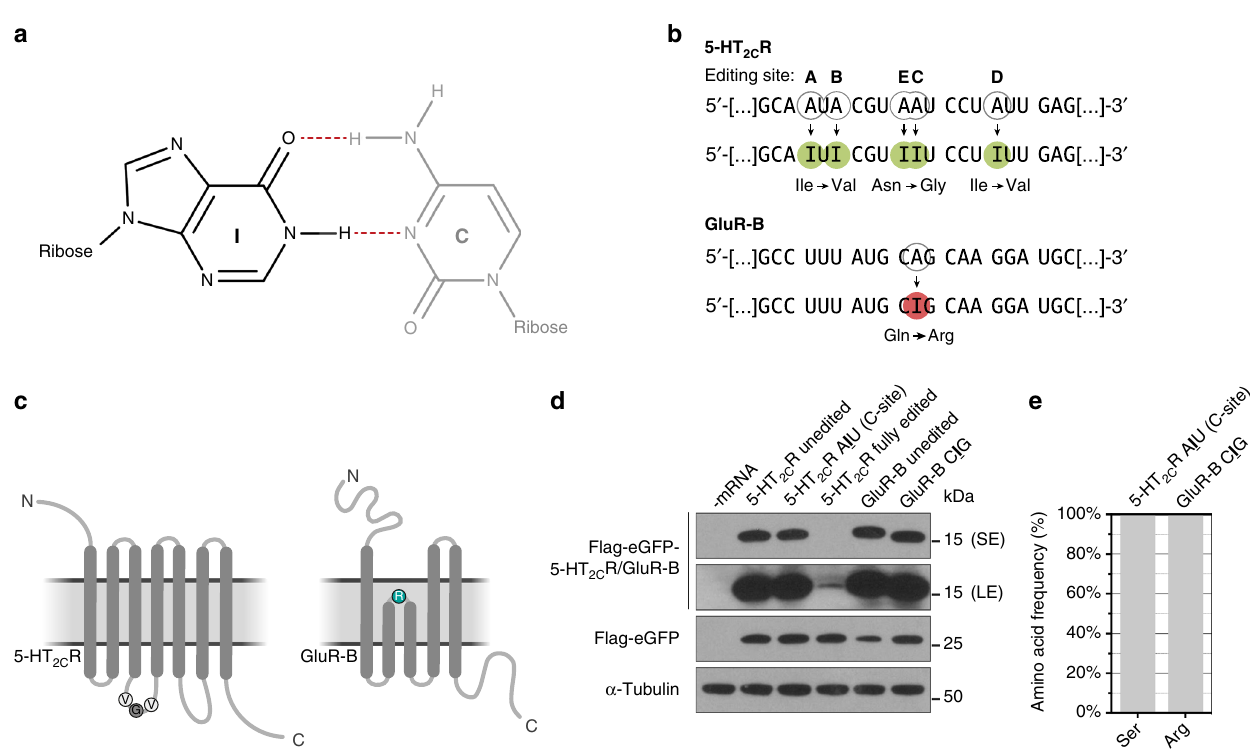
Fig. 4 Inosine is a non-standard nucleotide present in naturally occurring mRNAs. a The I – C base pair forms two hydrogen bonds within the W – C geometry. b The mRNAs of 5-HT 2C R and GluR-B are subject to A-to-I editing, thereby altering their genetic code. The editing sites are encircled. c Schematic representation of 5-HT 2C R and GluR-B proteins with the affected amino acids highlighted. d The I-containing mRNAs were transfected into HEK293T cells and the translation products were analyzed by western blotting (SE short exposure, LE long exposure). e The identity of the incorporated amino acids was determined by